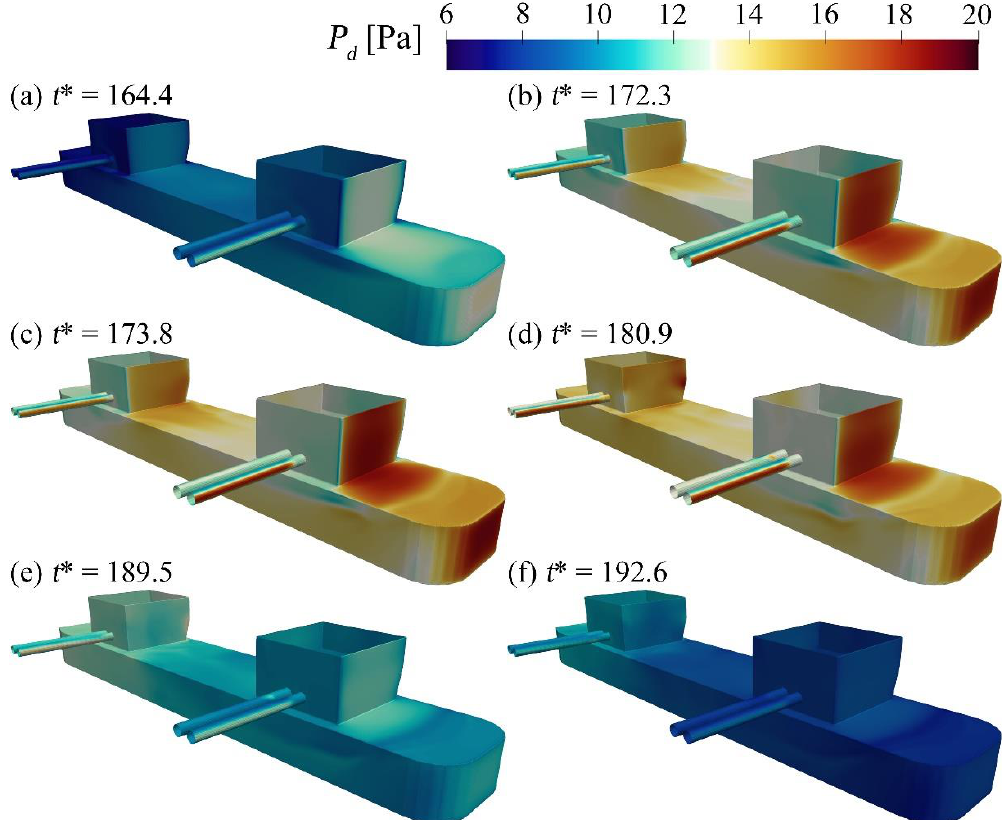
Figure 8. Dynamic pressure distribution around the platform versus dimensionless time for Case A2. P d is the dynamic pressure.